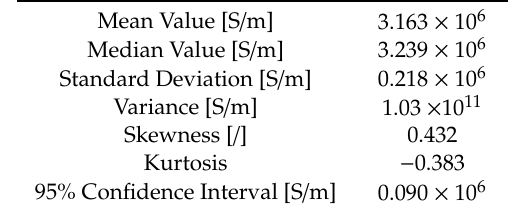
Figure 10. A normalized probability density graph for effective electrical conductivity data of a silver/epoxy nanocomposite system with a particle size of 3 nm, tunneling distance of 1.5 nm, and 30 vol% filler loading.